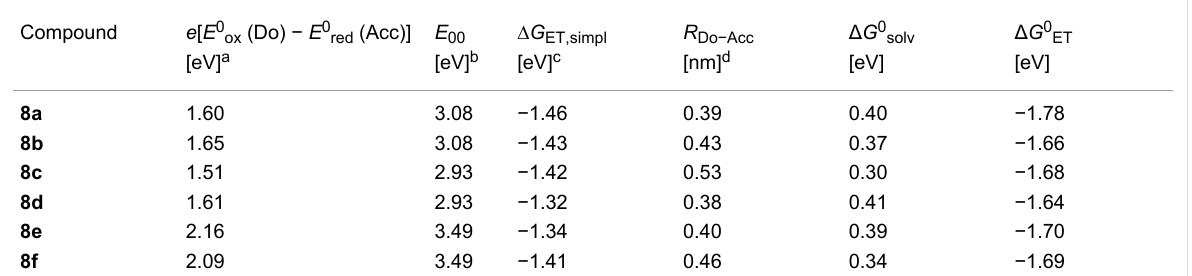
Table 4: Calculation of the Gibbs free energies for the simple electron transfer Δ G ET,simpl , for the solvation , and the electron transfer according to the Weller approximation of the dyads 8 .